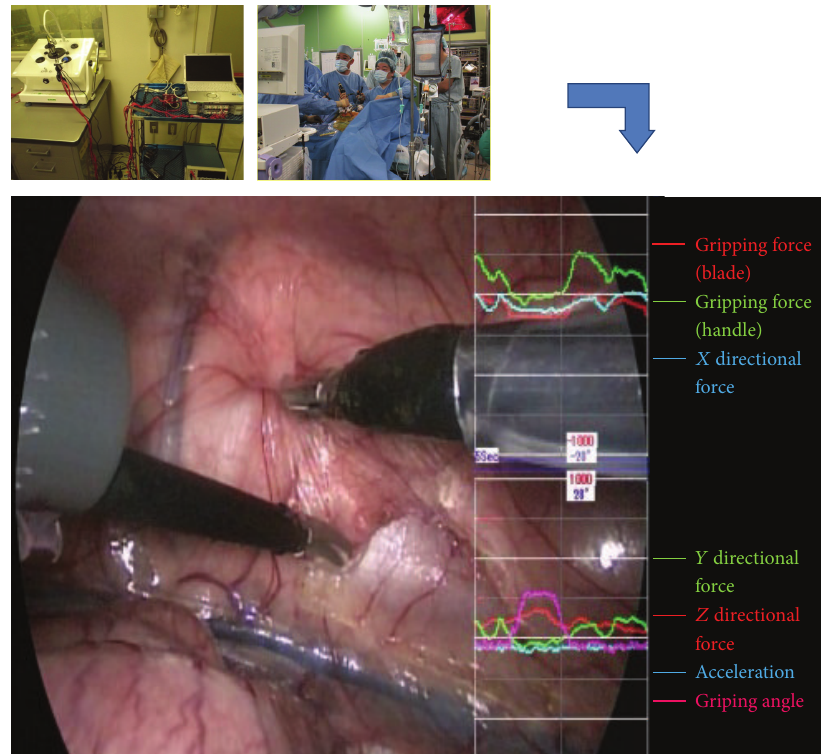
Figure 4: To synchronize the acquired physical quantities, such as the reaction force, with the corresponding surgical operations, we adopted a method to overlap a plotted graphical image of quantitative data.